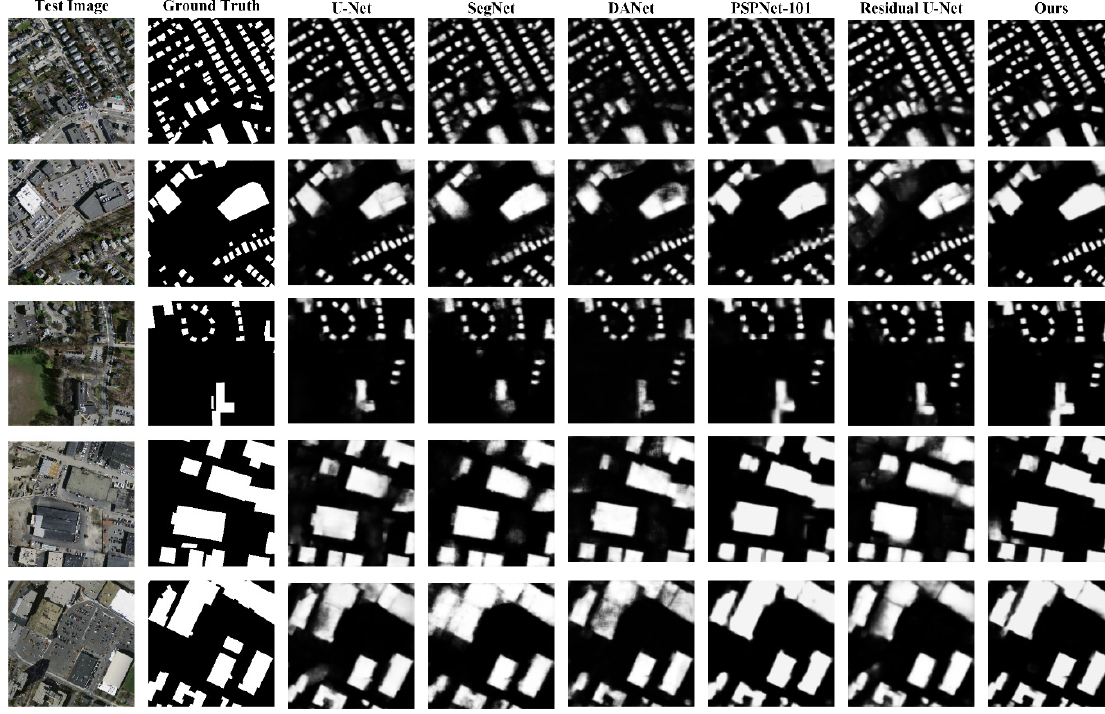
Figure 15. Several visual results of comparisons tested on the Massachusetts Building dataset.